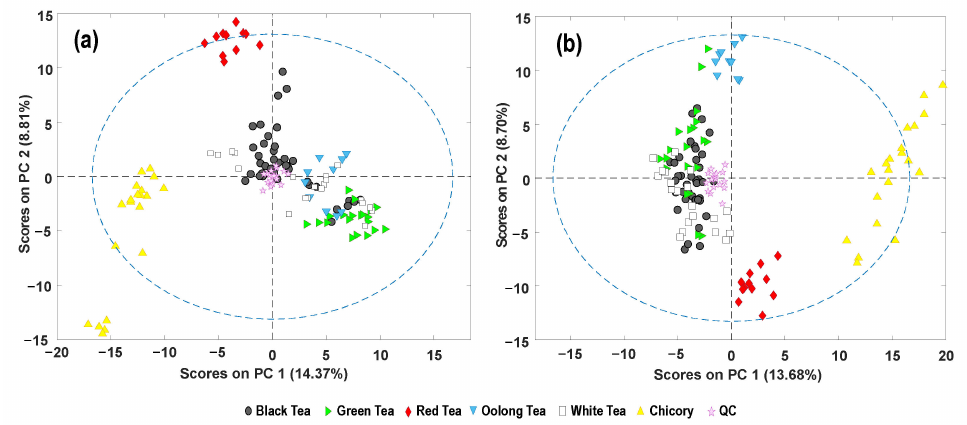
Figure 3. Exploratory PCA score plots of PC1 vs. PC2 when using FIA-MS fingerprints registered in ( a ) negative- and ( b ) positive-ionization mode as sample chemical descriptors.